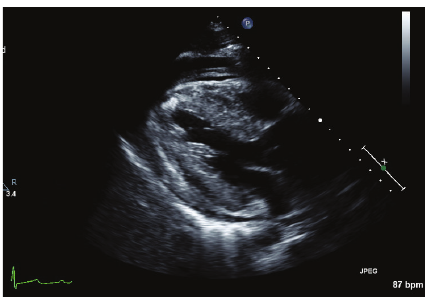
Figure 3: Echocardiogram showing left ventricular hypertrophy and pericardial effusion.